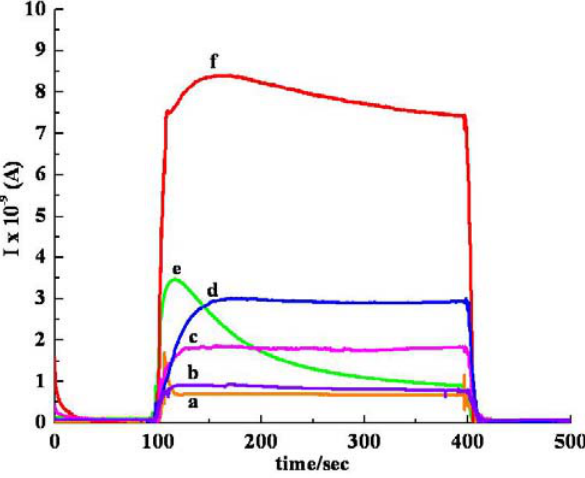
Figure 7. Response profile obtained for all analytes by sa MWCNT/Nylon-6 nanofibers at room temperature: (a) trichloromethane , (b) THF (c) EA, (d) ethanol, (e) acetone, (f) DCM.